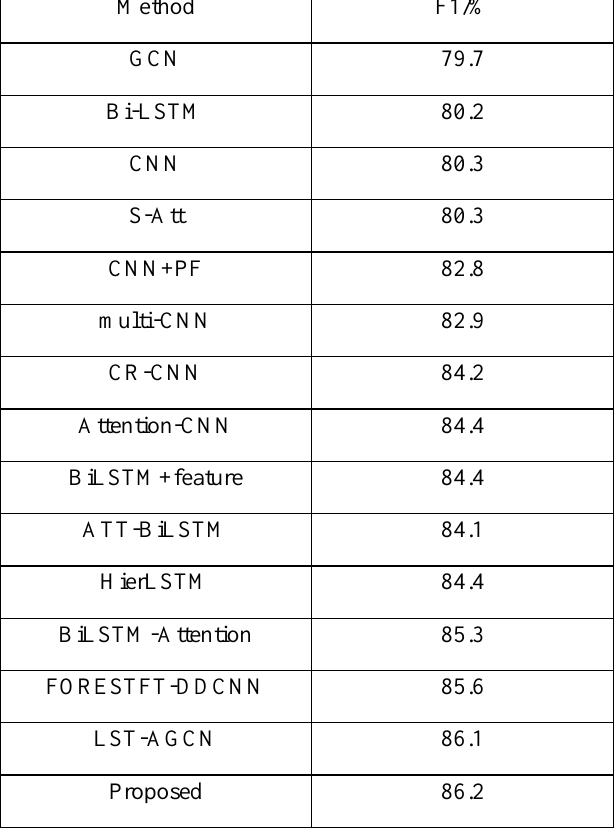
Table 5. F1 values of 15 methods on the